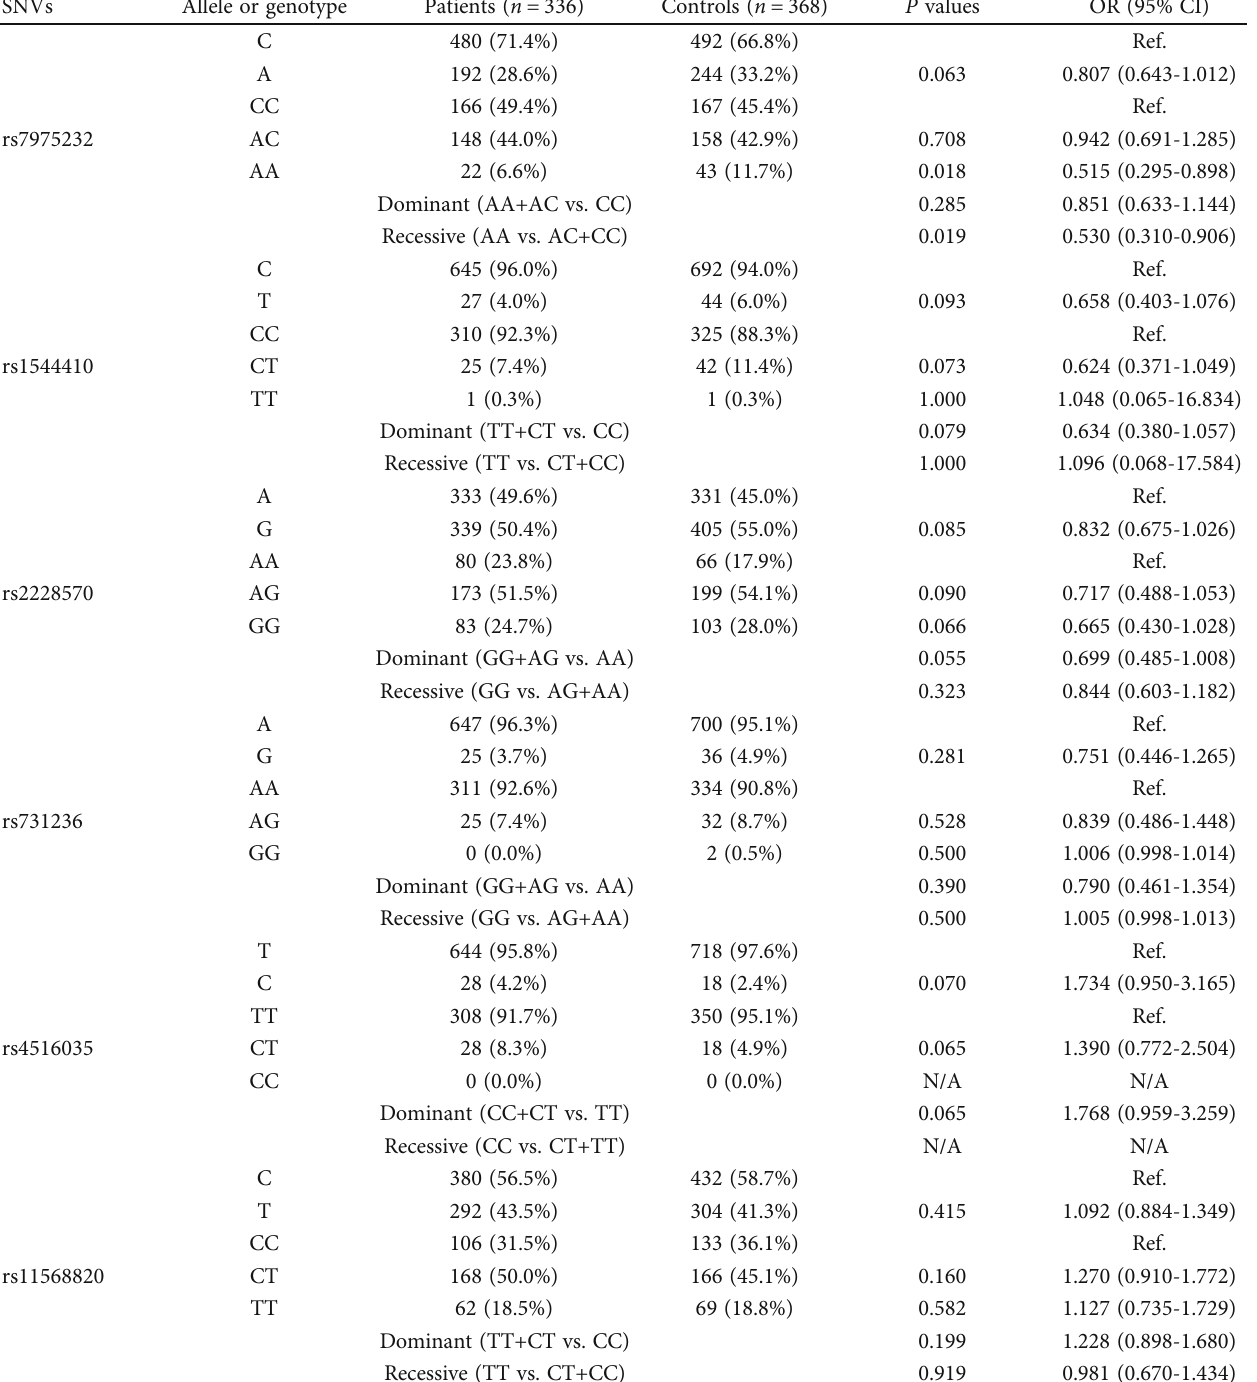
Table 3: Associations between the six VDR genetic SNVs and susceptibilities to late